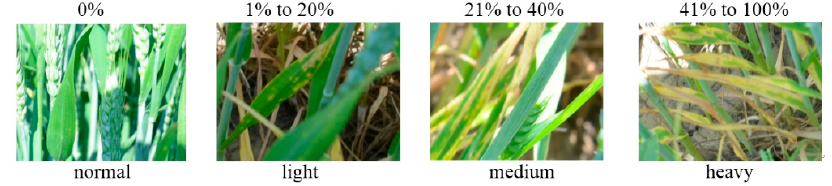
Figure 4. Disease severity categories established to represent the wheat health state.